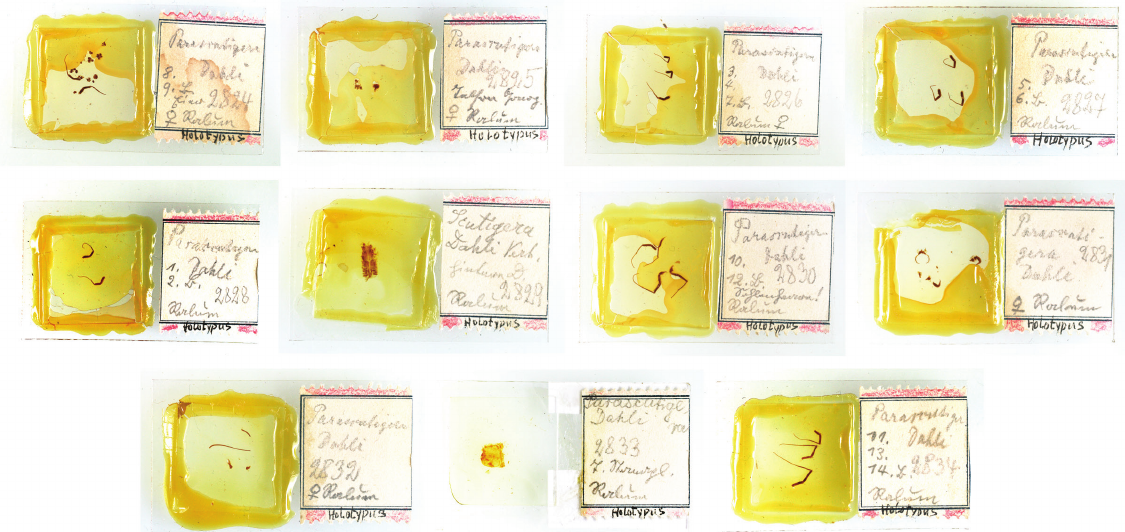
Figure 2. Examples of microscope slides from the Karl Verhoeff collection bearing dissected parts of the anatomy. ZMB 3840a–k, the complete type series of slides belonging to Parascutigera dahli Verhoeff, 1904 collected by Friederich Dahl from Ralum in Papua New Guinea; Verhoeff slide numbers 2824–2834. Type material in the slide collection is marked with red lines on the labels and usually complements alcohol